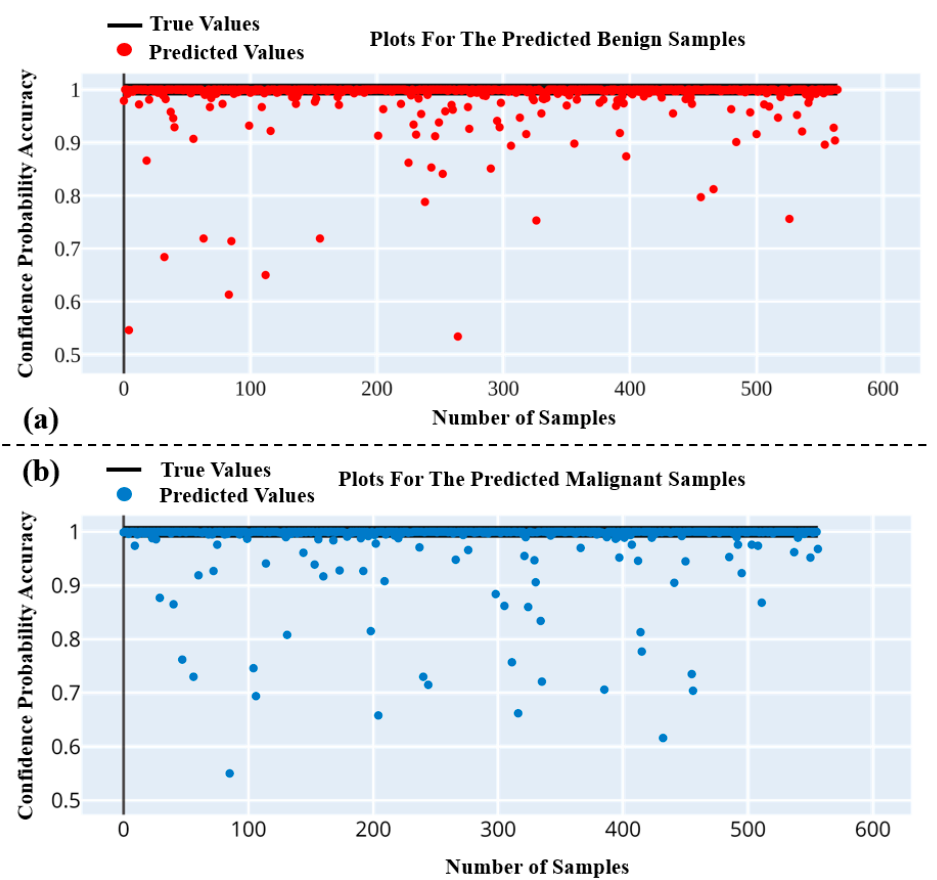
Figure 14. Quantile-quantile plot for true and predicted probabilistic values. ( a ) Samples that were benign and had true positive predictions. ( b ) Samples that were malignant and had true negative predictions.